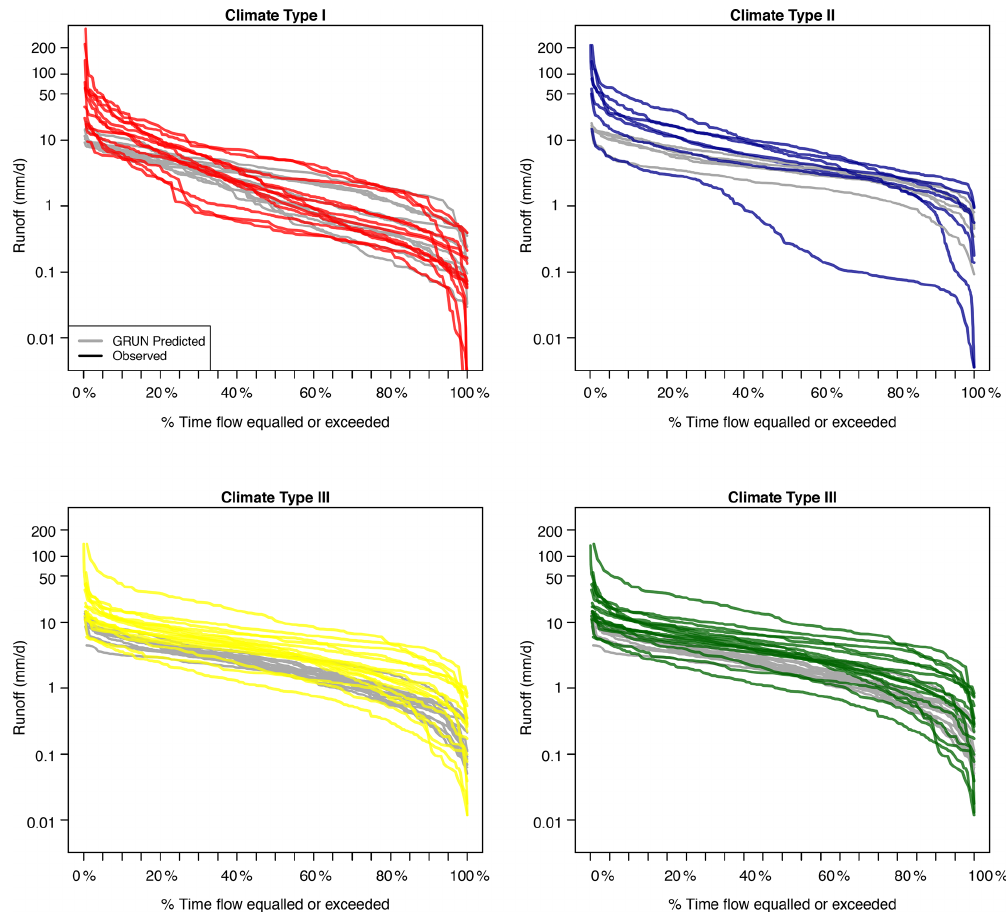
Figure 5. Flow Duration Curves (FDC) of individual catchments by climate type. For each climate type, the observed (colored) and GRUN- predicted (grey) runoff distributions are shown for each catchment. These plots represent the rank ordered data shown in Fig. 4. FDC comparisons for each individual catchments are compiled in Fig.